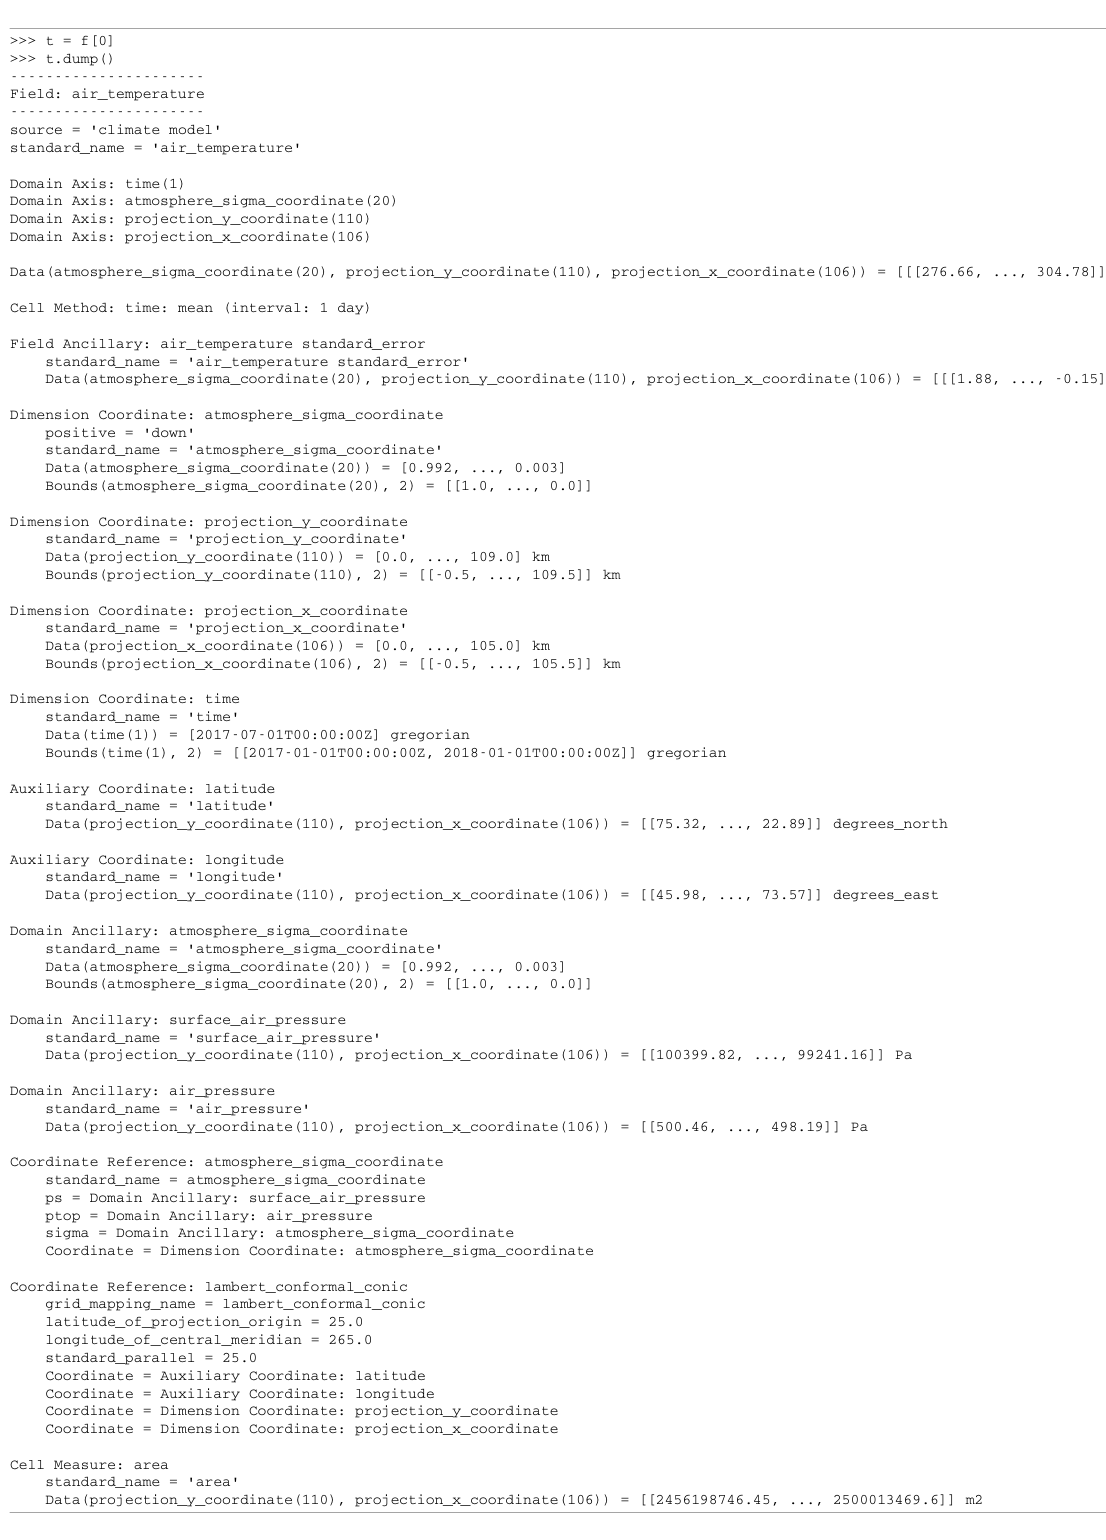
Figure 17. A detailed inspection of a field object’s